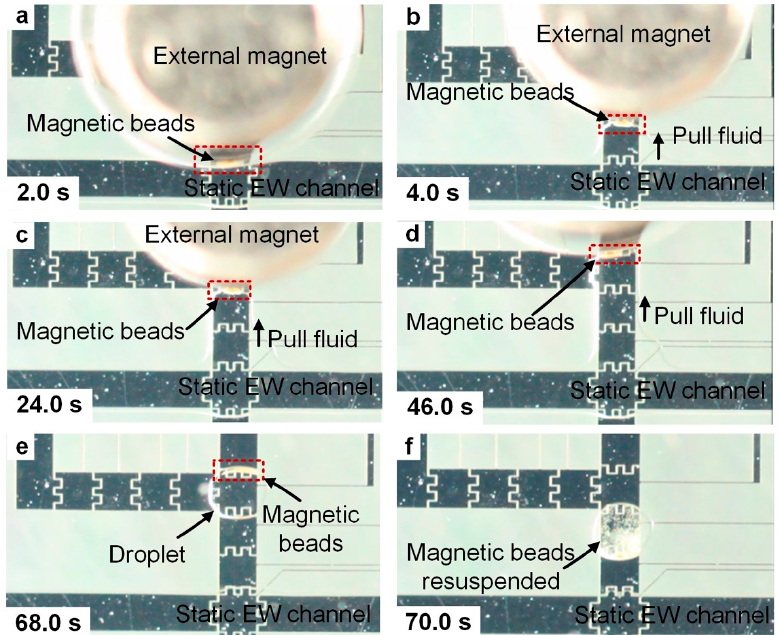
Figure 5. The splitting of a droplet of capture antibody functionalized magnetic beads from a static electrowetting channel. ( a ) The flow was completely stopped. A magnet was still held in place to aggregate the magnetic beads. ( b – d ) The side electrodes were turned on to pull the bead-containing fluid from the channel, and the magnet was slowly moved in the same direction to ensure that the beads were still aggregated. ( e ) A droplet of magnetic beads was split from the channel. (f) The beads were re-suspended after agitation.